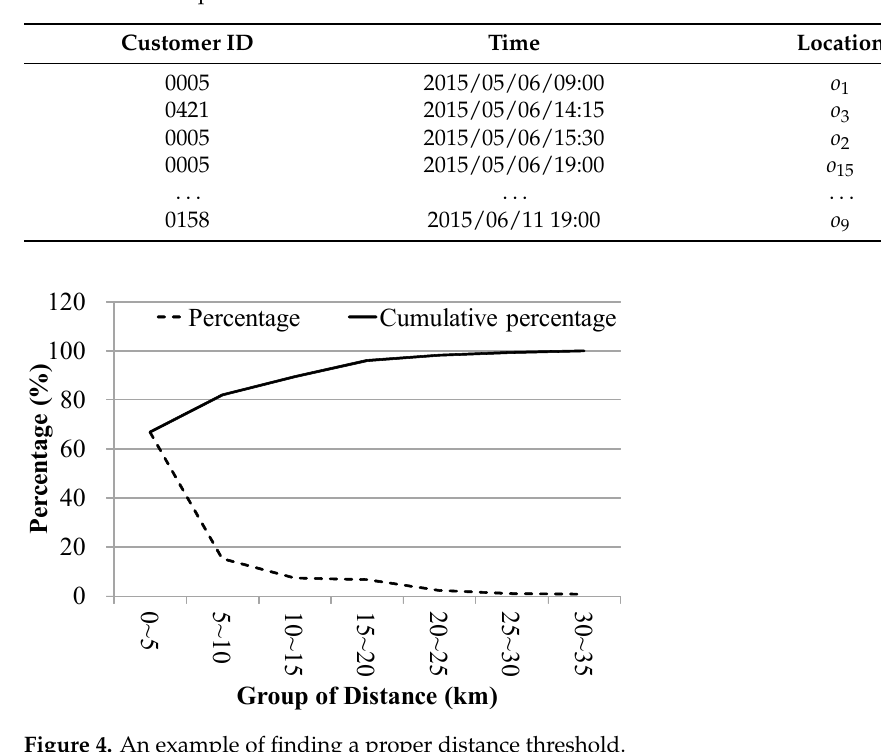
Table 4. An example of check-in data.